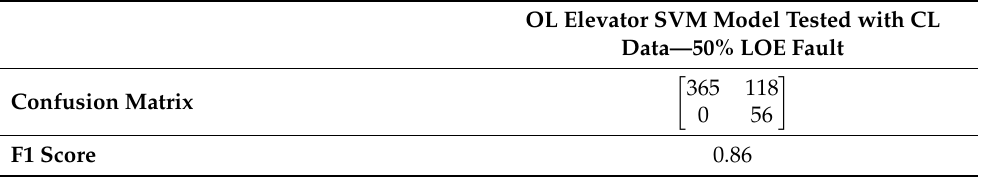
Table 10. Elevator SVM model trained for an open-loop system and tested with closed-loop data.